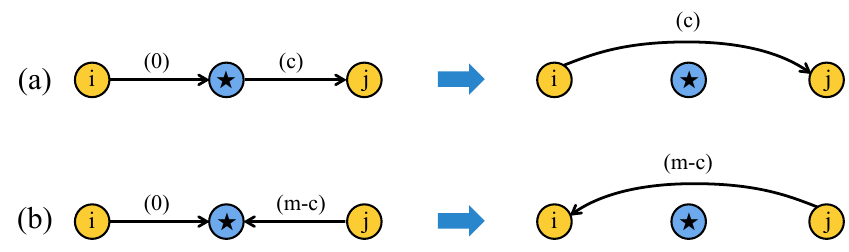
Figure 2. (a) Composition of arrows into a meson. (b) The same process interpreted as anticom-